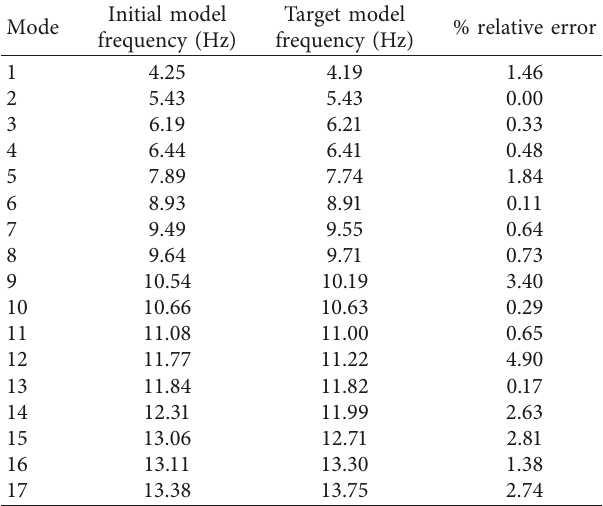
Figure 27: MAC of configuration 3 simulated-target model. Table 16: Fuel configurations for configuration 3 simulation.